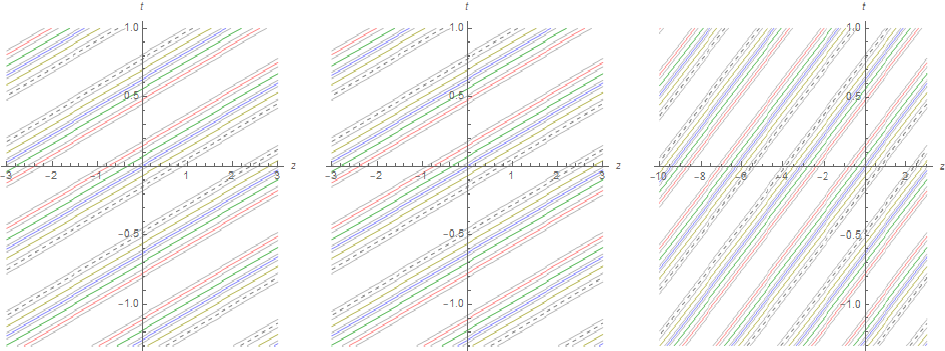
Figure 28. Shows contour shapes for Figure